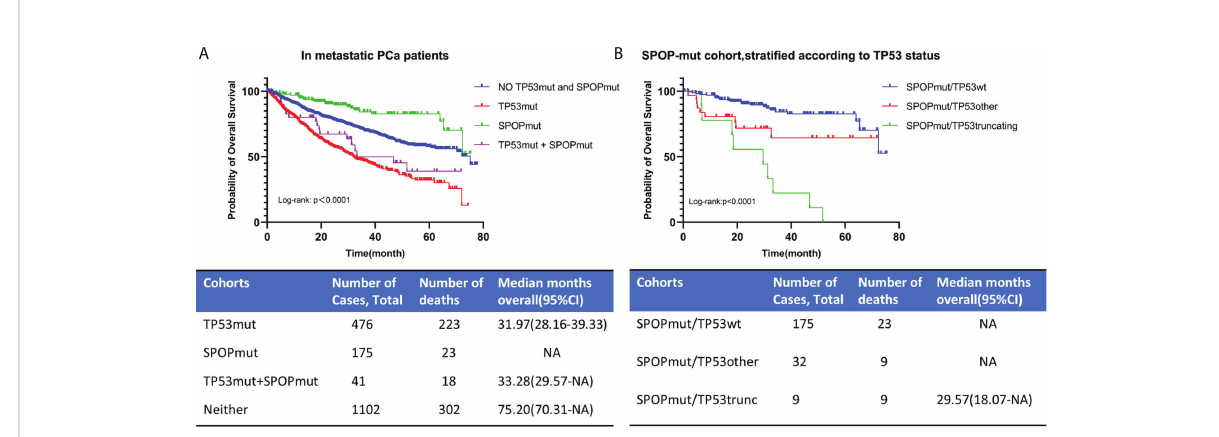
FIGURE 7 OS for metastatic PCa in different TP53/SPOP mutation groups (A) . Patients with SPOP mutations were further strati fi ed according TP53 mutation status (B) . TP53wt, TP53 wild type; TP53mut, TP53 mutation; SPOPmut, SPOP mutation; OS, overall survival; CI, con fi dence